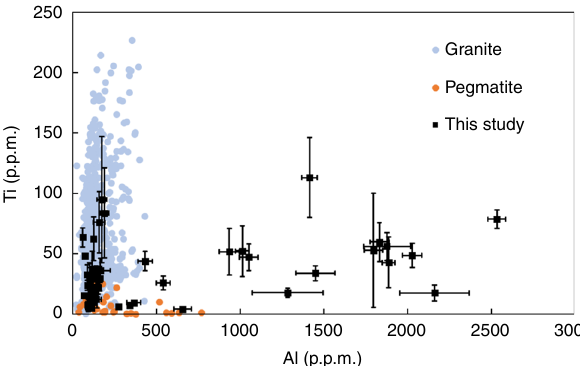
Fig. 4 Ti versus Al concentrations in quartz from granites and pegmatites. Granitic data compiled from Ackerson et al. 60 and pegmatite data from Garate-Olave et al. 61 and Götze et al. 15 . Error bars represent 3 σ . Data for this study are from point